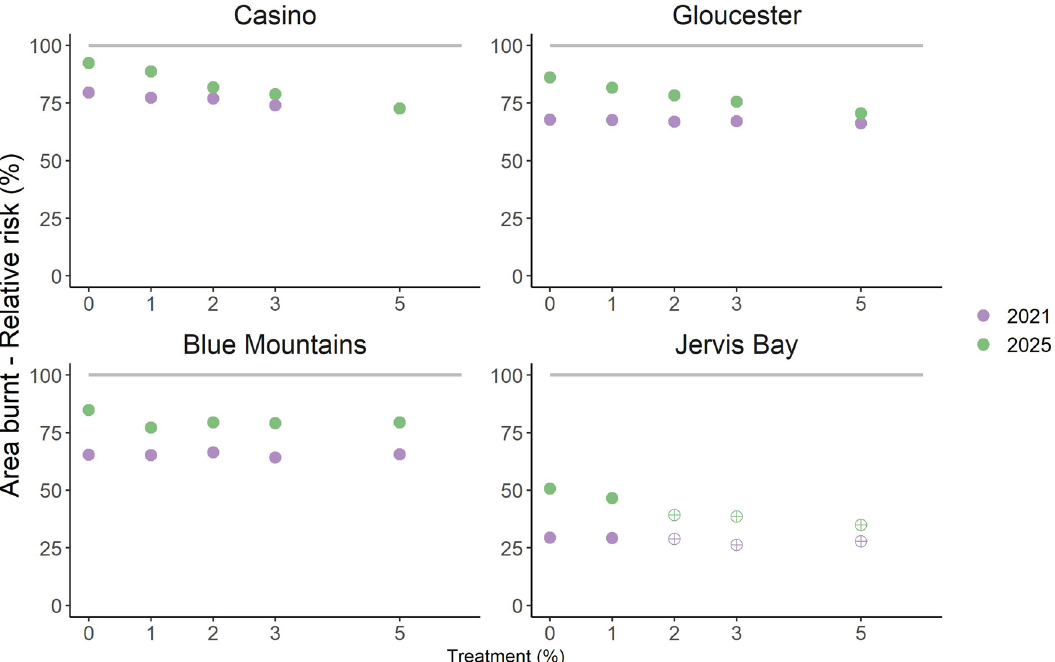
Figure 5.. Future residual risk trajectory of area burnt by wildfire in the Casino, Gloucester, Blue Mountains and Jervis Bay case study areas. Risk is relative to a control scenario with pre-2019–2020 fuel load and no prescribed burning (the 100% level on the y-axis, indicated by line). Markers represent different annual treatment rates, colour indicates time period (blue = 2021 i.e. two years after 2019–2020 fire season, orange = 2025 i.e. six years after 2019–2020 fire season). In Jervis Bay the markers for 2, 3 and 5% p.a. treatment reflect edge treatment rates, with landscape treatment capped at 1% p.a. due to the very large area burnt during the 2019–2020 season (81% of the study